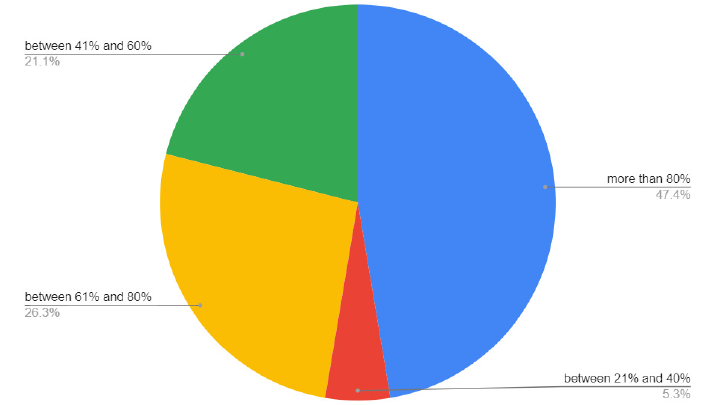
Figure 16. Amount of material use in the MOOC.